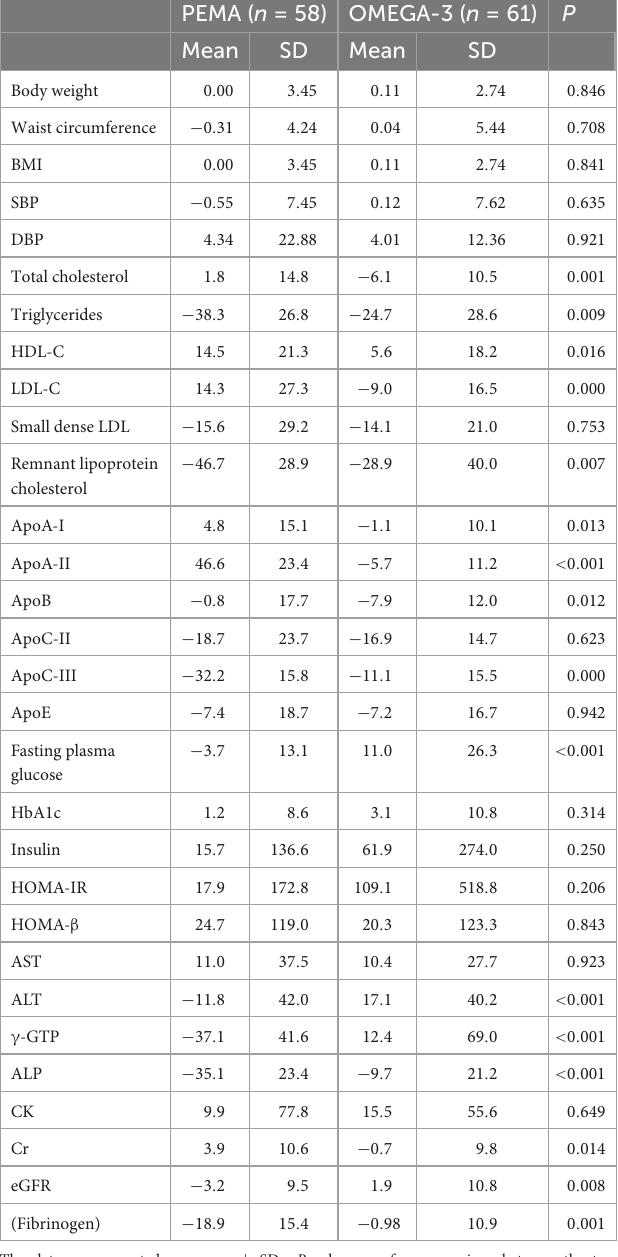
TABLE 4 Percentage changes in clinical variables from baseline to week